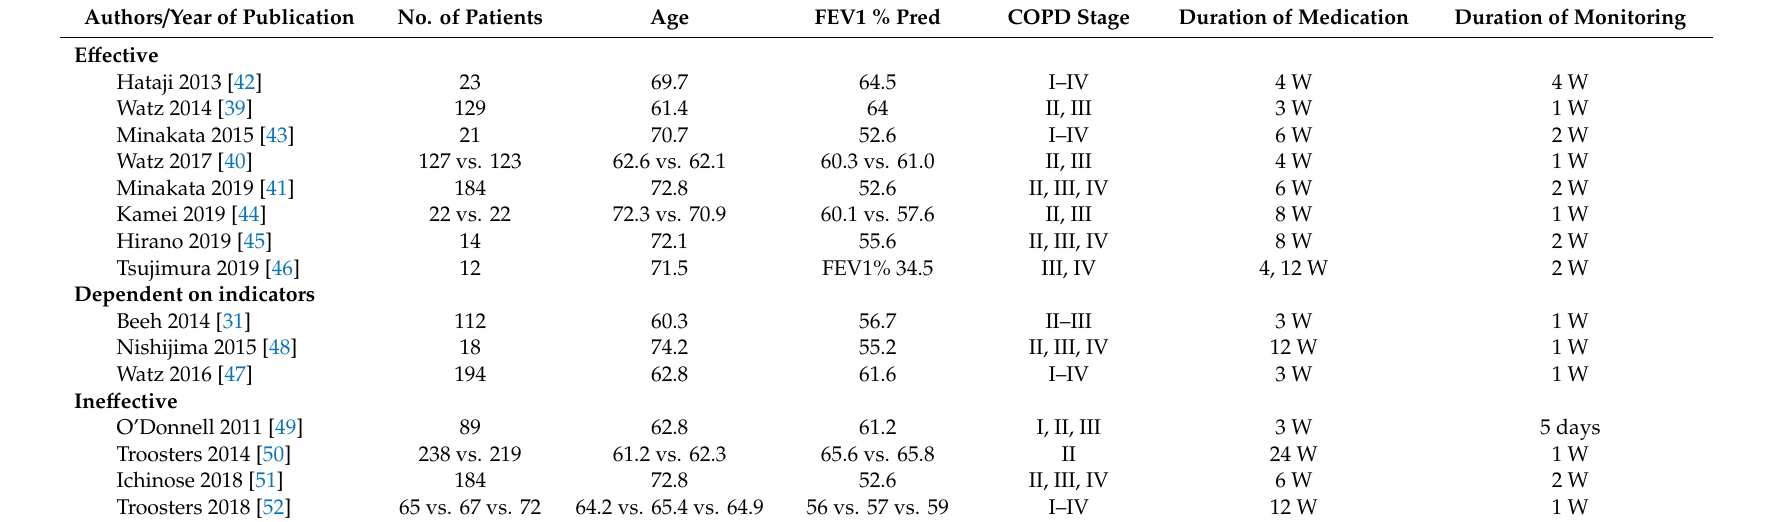
Table 3. Patients characteristics of the